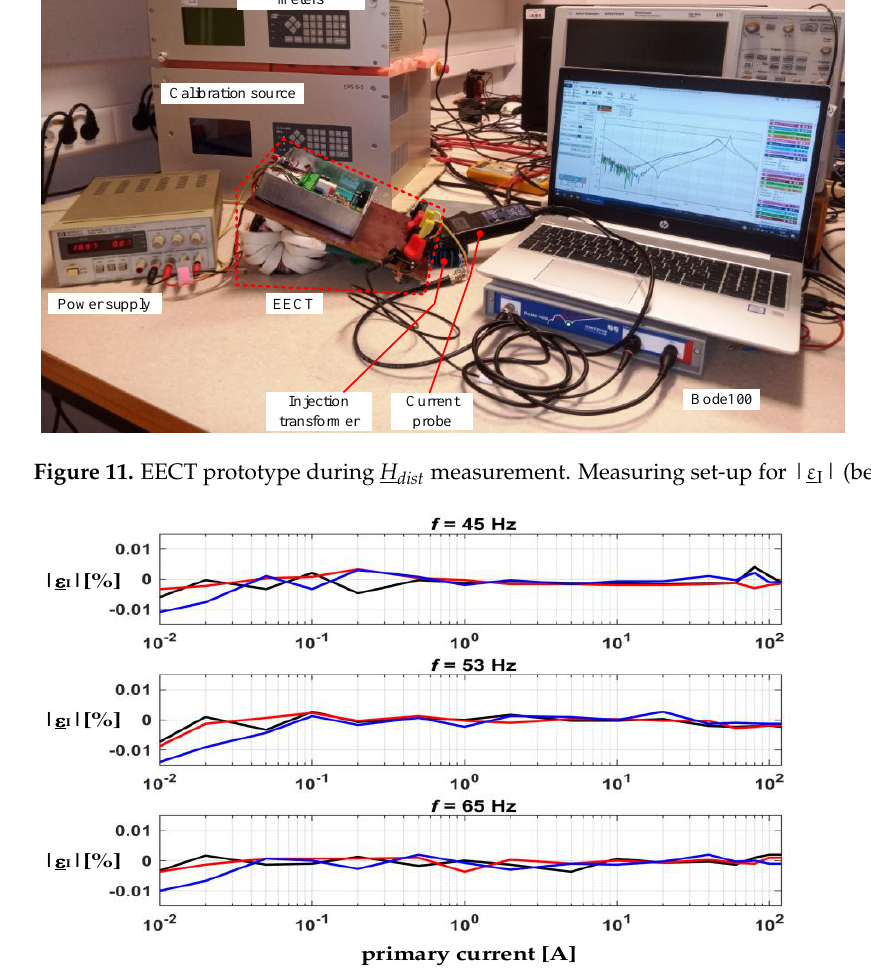
Figure 12. Current error  ε I  in % at different frequencies and PF : 0.5 capacitive (blue), 1 (red), 0.5 inductive (black). 0.5 inductive